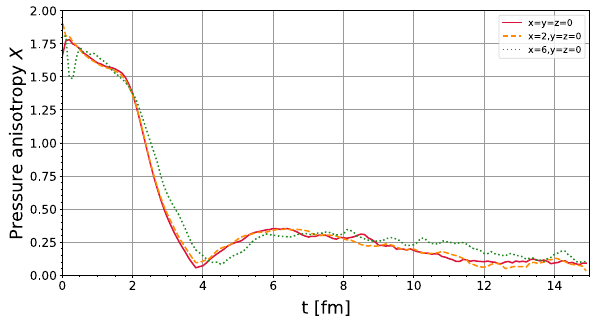
Fig. 26 Time evolution of X at x = 0, 2, 6 fm and y = z = 0 fm in Au+Au collisions at E